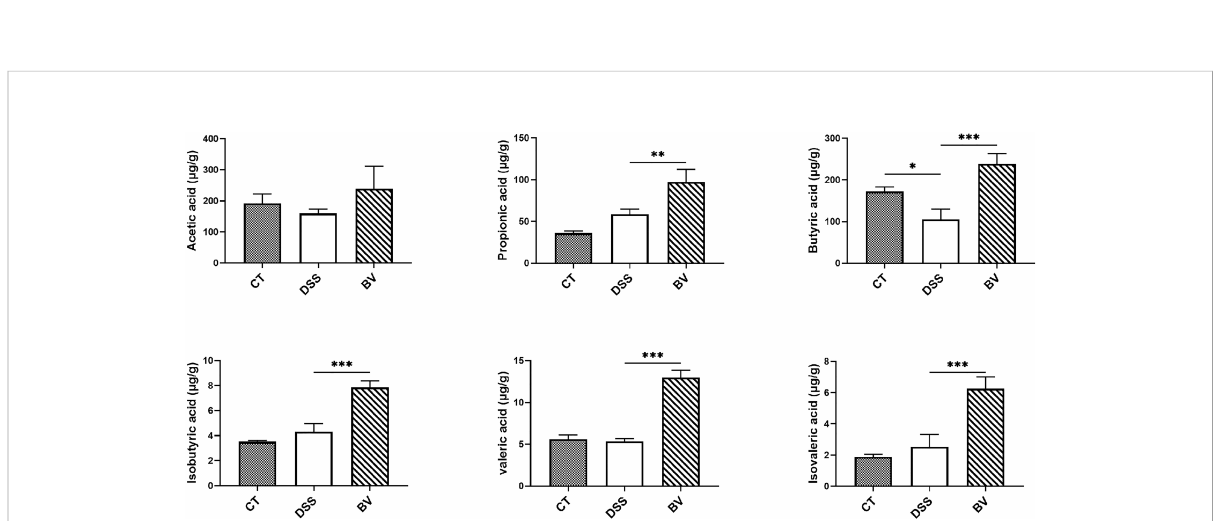
FIGURE 6 Comparison of fecal short chain fatty acids (SCFAs) pro fi les. Statistical comparison was implemented by a one-way ANOVA followed by Tukey ’ s multiple-comparison test. Values represent the mean ± standard deviation. Signi fi cance levels are shown as * P < 0.05, ** P < 0.01, *** P < 0.001.